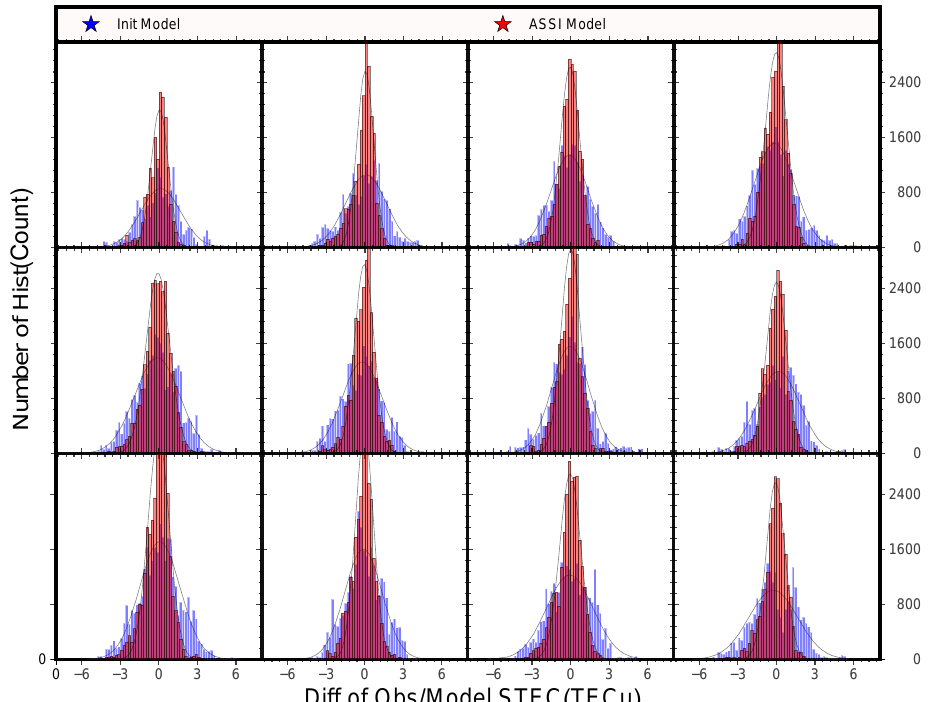
Figure 8. Distribution of residual statistics of top region assimilation model and podTec observational data on DOY 10, 2008: blue bars, the model constructed by the method of Wu et al.’s; and red bars, the model assimilated using podTec with the constructed